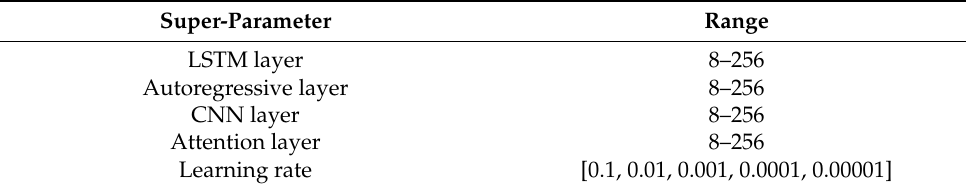
Table 1. Ranges of model super-parameters used in